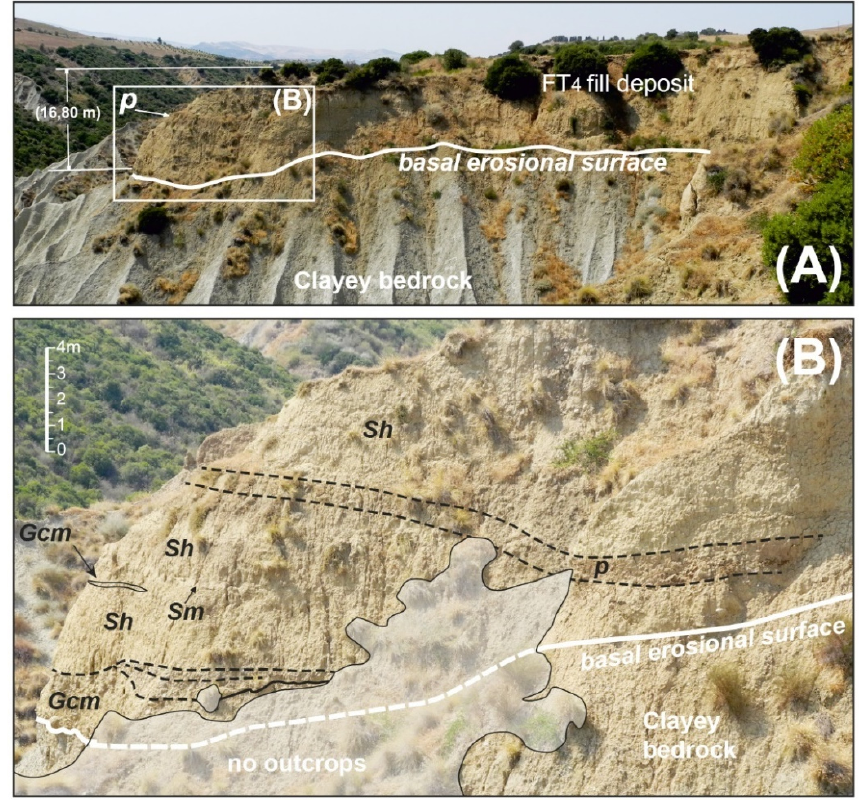
Figure 7. Panoramic view of the Cugno Longo terraced unit ( A ). In frame ( B ) is a detail of the FT 4a depositional facies architecture and the location of the palaeosoil (P). See Table 1 for facies code and interpretation.